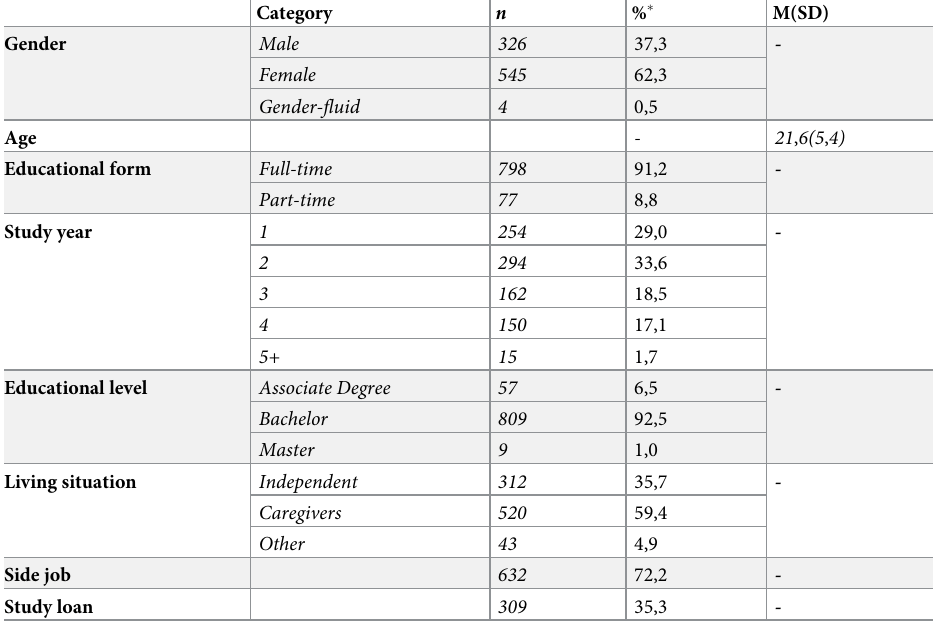
� Percentages are rounded to a